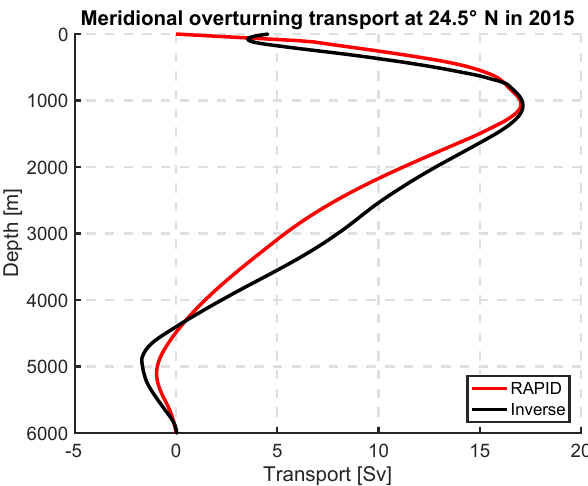
Figure 14. Meridional overturning transport at 24.5 ◦ N in 2015, cal- culated from the inverse method (black) and RAPID array